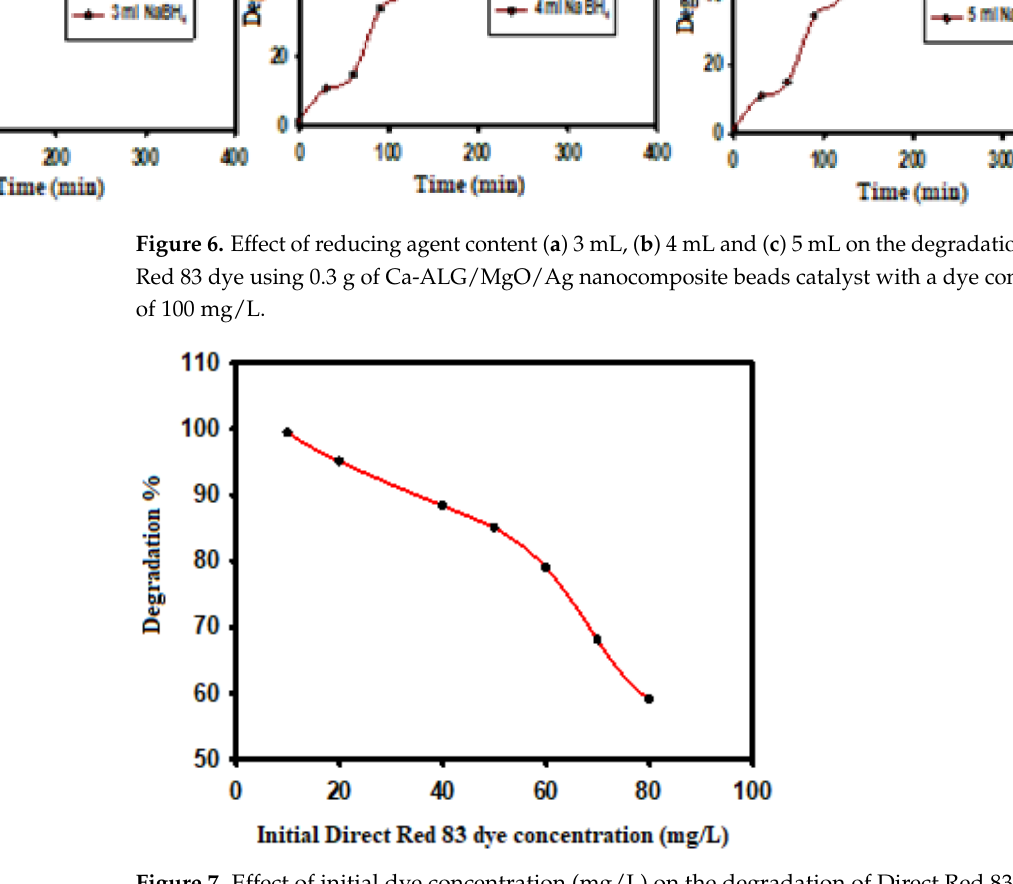
Figure 7. Effect of initial dye concentration (mg/L) on the degradation of Direct Red 83 dye using 0.3 g of Ca-ALG/MgO/Ag nanocomposite beads as a catalyst and 3 mL of NaBH 4.